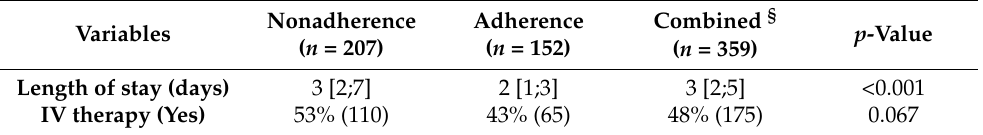
Table 2. Total admission characteristics according to adherence to guidelines for the placement of VADs. Data are presented as the median (I, III quartile) for continuous variables and as percentages (absolute numbers) for categorical